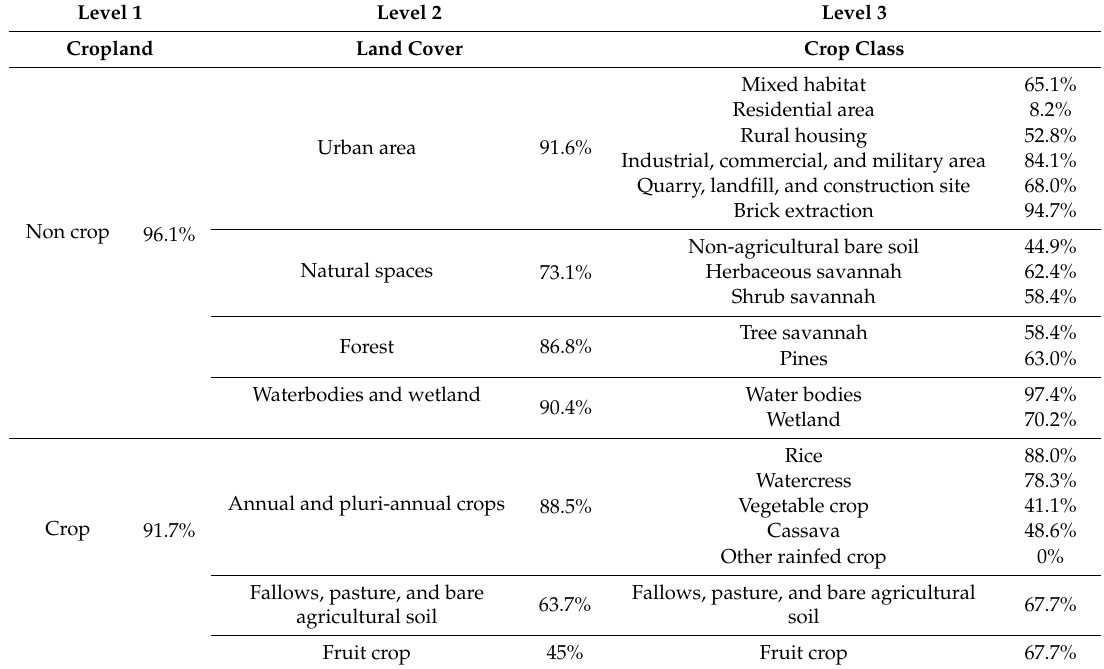
Table 4. F1-score for each class and nomenclature